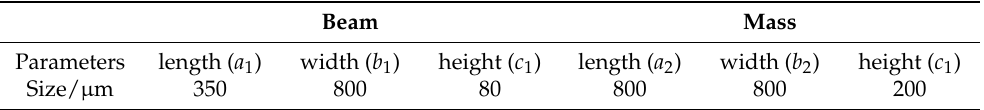
Table 1. Structural parameters of the HGMA.